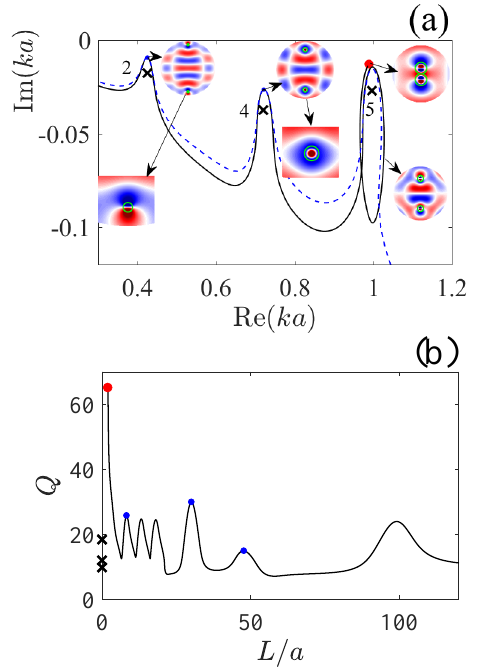
Figure 8: Evolution of symmetric and antisymmetric hy- bridizations of higher Mie dipole resonant modes (a) and respective Q factors (b) with the distance.